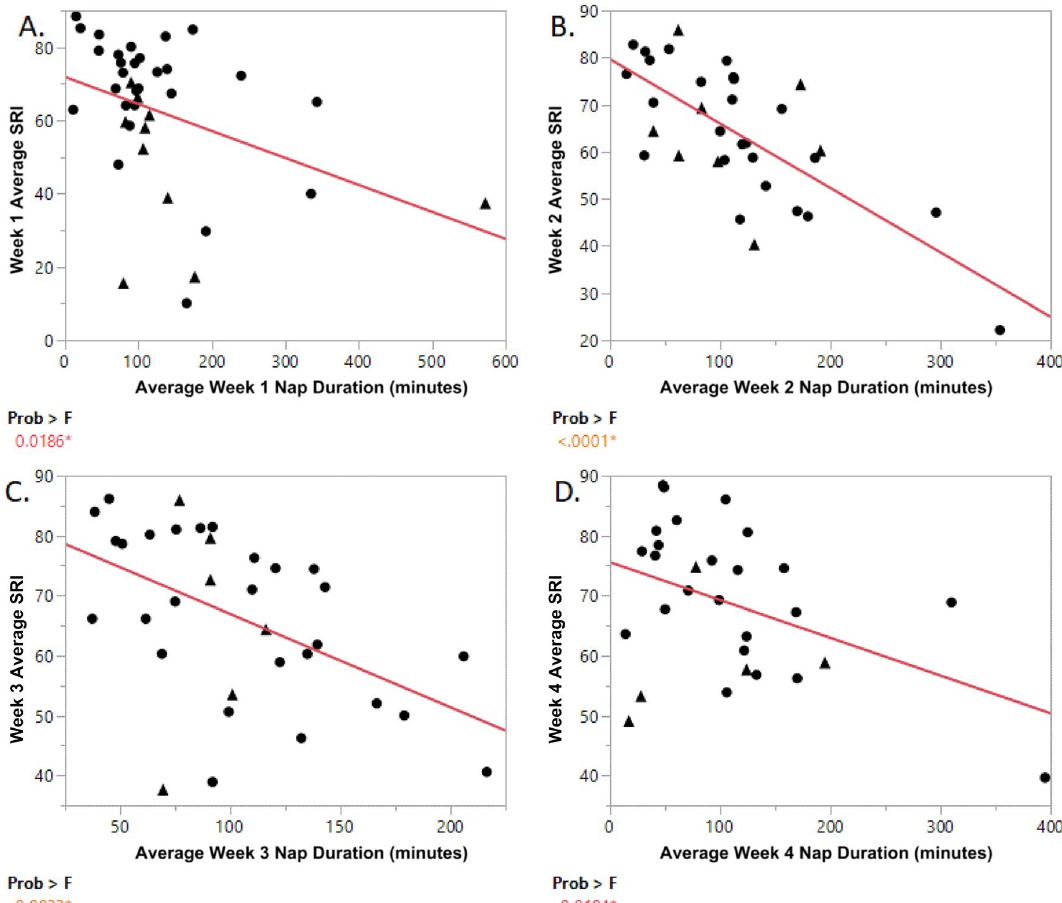
Figure 2. Weekly SRI versus weekly nap duration. Weekly SRI versus weekly average nap duration. ( A ) Week 1 SRI (x-axis) versus average week 1 nap duration (y-axis). Pearson correlation r = − 0.38, p = 0.018. ( B ) Week 2 SRI (x-axis) versus average week 2 nap duration (y-axis). Pearson correlation r = − 0.71, p < 0.0001. ( C ) Week 3 SRI (x-axis) versus average week 3 nap duration (y-axis). Pearson correlation r = − 0.49, p = 0.003. ( D ) Week 4 SRI (x-axis) versus average week 4 nap duration (y-axis). Pearson correlation r = − 0.43, p =